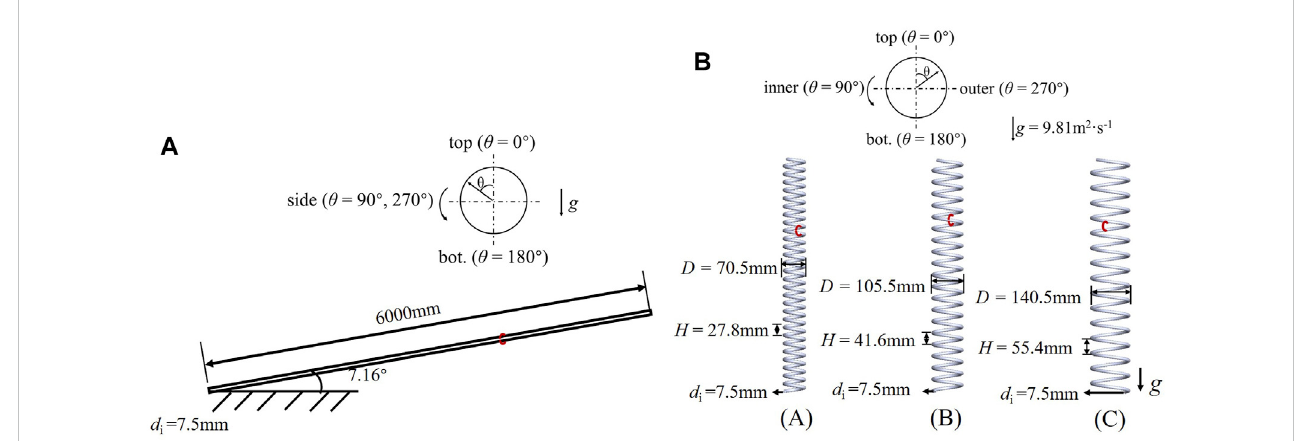
Structures and angular coordinates of the investigated tubes. (A) 7.16 ° inclined straight tube; (B) Helical